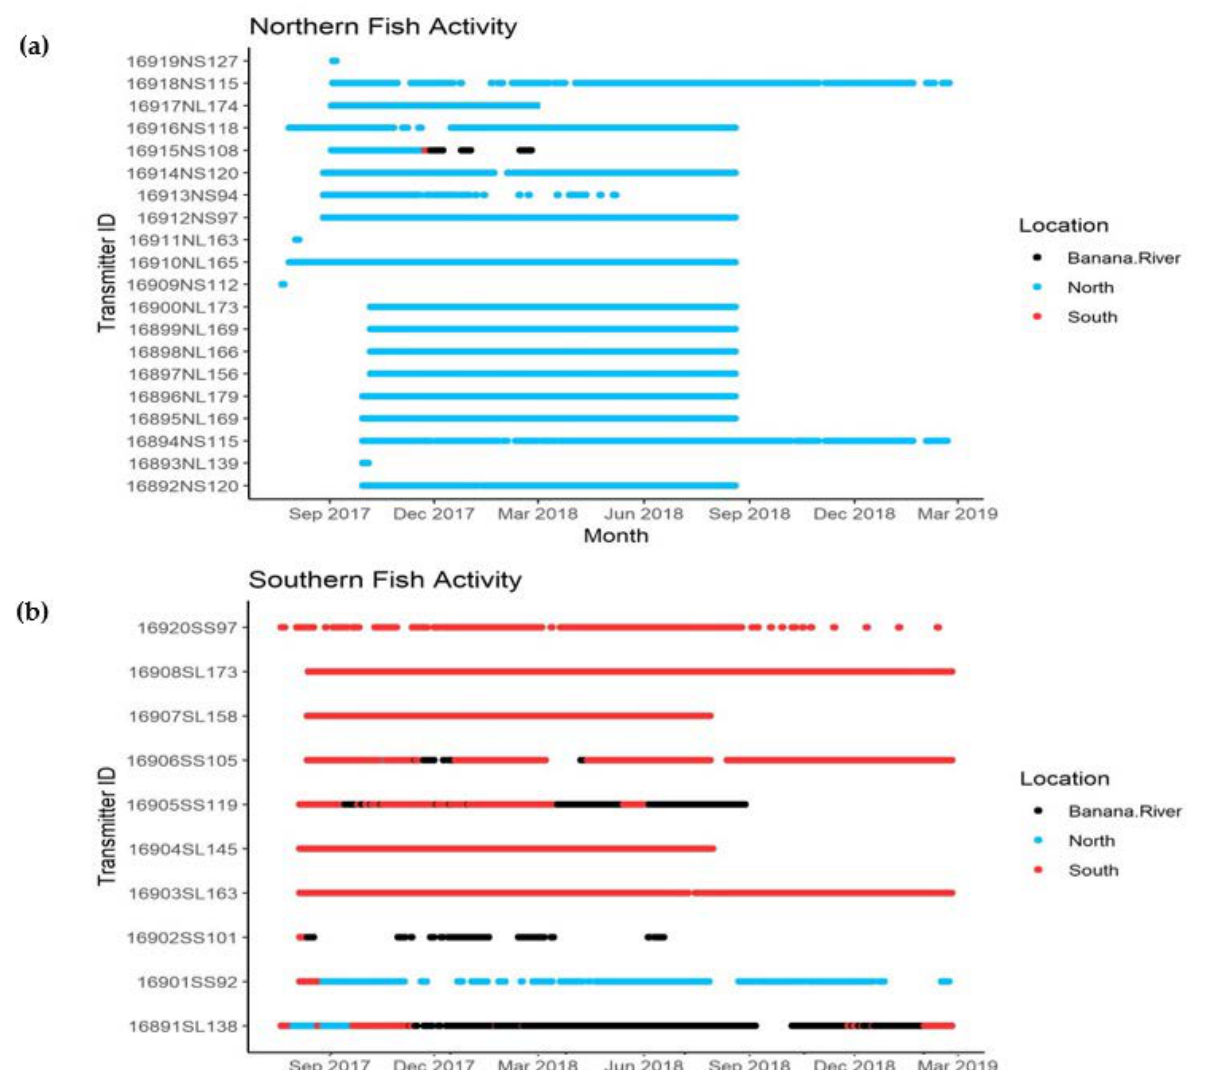
Figure 4. Abacus plot of individual fish captured in ITL impoundments activity over time. Detections in black represent Banana River receivers, blue points represent north impoundment receivers, and red points represent south impoundment receivers. Numbers following transmitter ID represent size class and individual head width measurements (cm); ( a ) Represents fish captured within the northern ITL impoundment. ( b ) Represents fish captured within the southern ITL impoundment. Extent of use area was best described by the interactive model of water temperature and pH; there were incremental gains in model predictive ability by also including the interactive effect of either water depth, wind speed, or salinity. The mean ( ± sd) daily distance traveled by large fish (2913.0 ± 1871.4 m) was greater than distances traveled by small fish (1647.7 ± 1572.0 m). DO concentration class was the most important abiotic variable to explain daily distance traveled by fish within the array. Mean fish daily distance traveled increased from 2745.3 ( ± 1721.3) m in normoxic conditions to 3304.7 ( ± 1154.3) m when dissolved oxygen concentration reached anoxic levels. Daily distance traveled was best described by the interactive model of DO concentration class, temperature, and